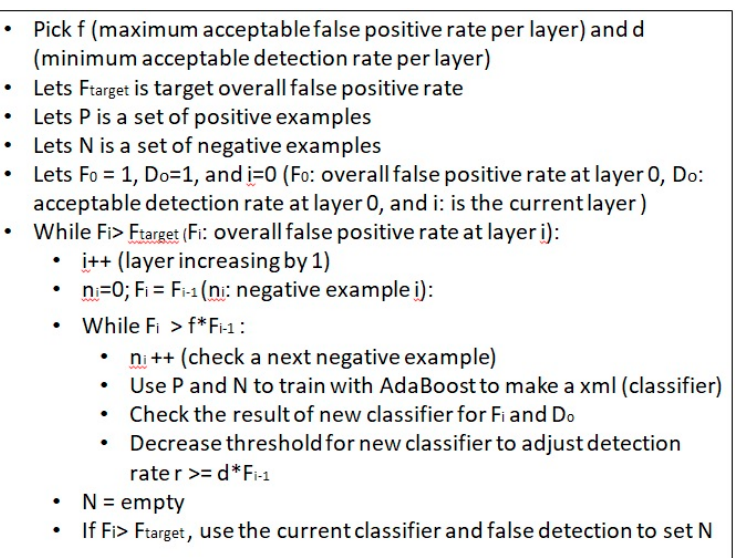
Figure 1. Haar-cascade algorithm pseudo code.